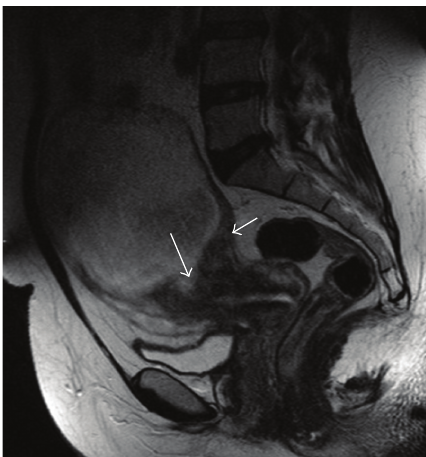
Figure 1: The gestational sac develops from the fundus with the presence of a sign of the spur (short arrow) and an extension of the contents of the bag in the thickness of the myometrium (long arrow). Note the exophytic development of trophoblastic tissue.